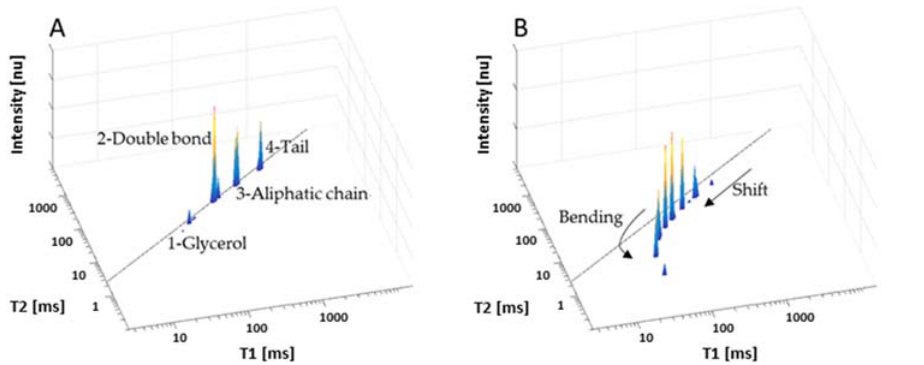
Figure 3. Chemical and morphological time-domain (TD) nuclear magnetic resonance (NMR) sensor 2D T 1 –T 2 relaxation times of linseed oil before ( A ) and after 120 h of thermal oxidation at 80 °C plus air pumping ( B ). Each peak corresponds to a proton population motion in a different segment of the linseed oil.